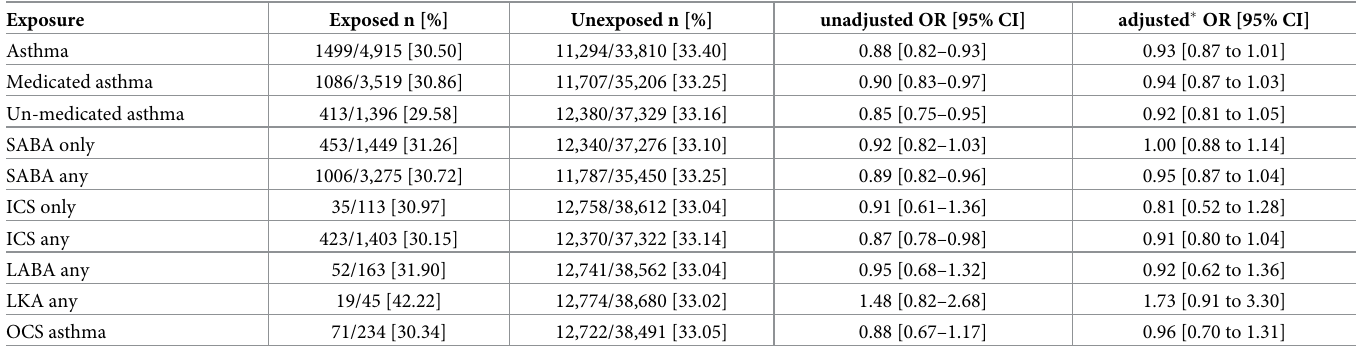
Table 6. Breastfeeding at 6–8 weeks (n =